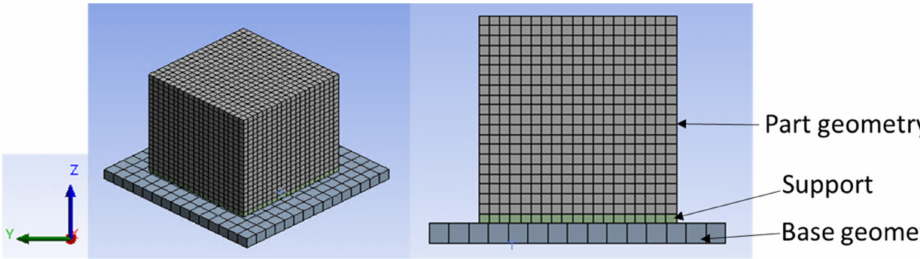
Figure 3. A schematic diagram of the rice paste printing